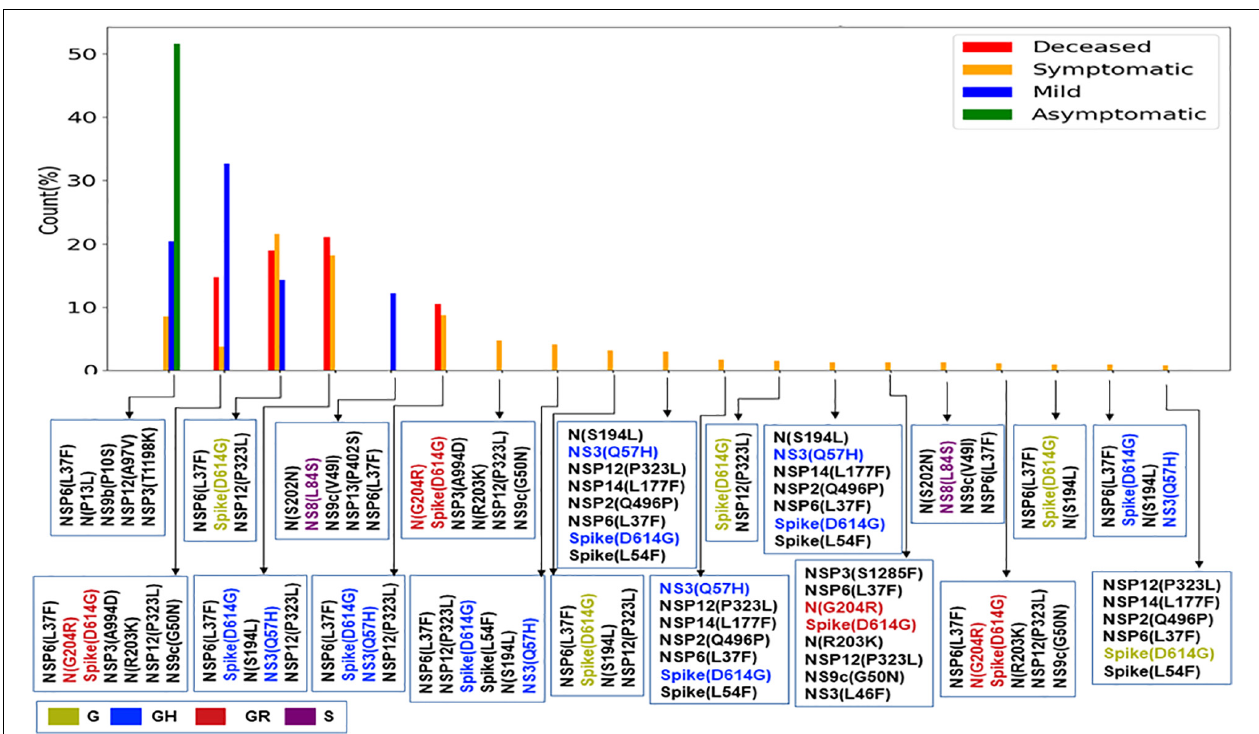
FIGURE 7 | Association of specific co-mutation patterns with the status of the COVID-19 patients from India. The frequencies of specific co-mutations are plotted with respect to the four status categories of COVID-19 patients: deceased, symptomatic, mild, and asymptomatic, respectively. G, GH, GR, and S clades defining mutations are marked in yellow, blue, red, and purple,